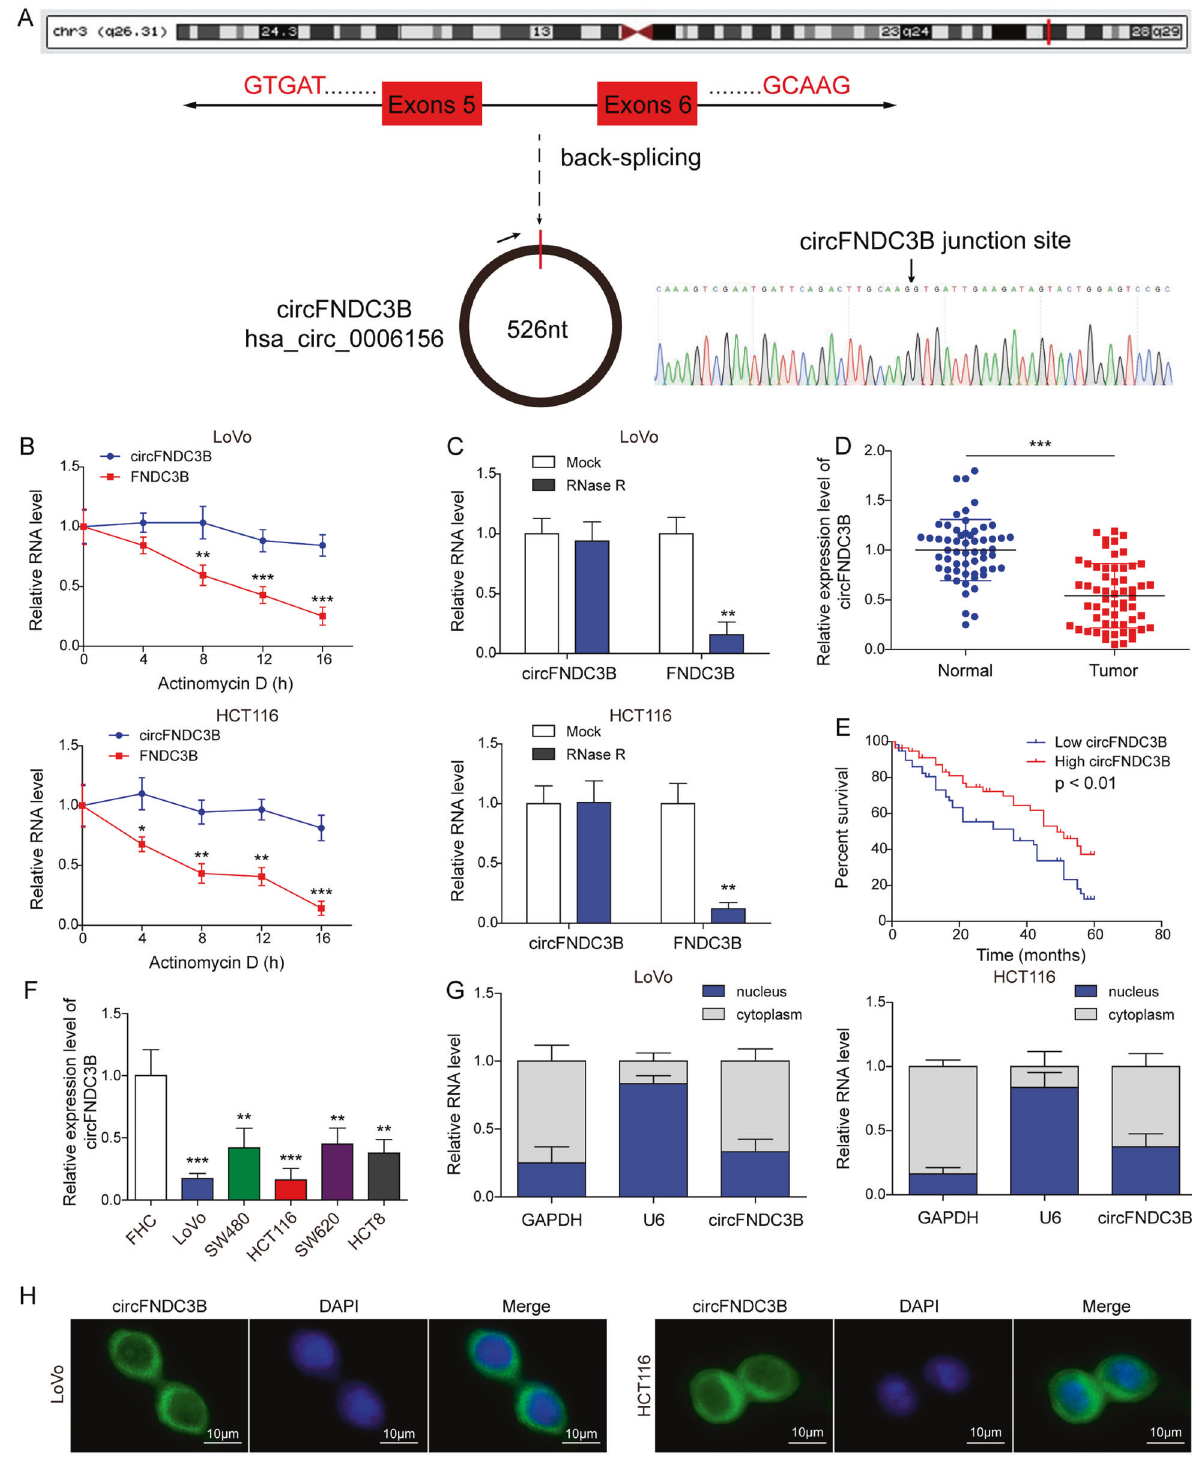
Fig. 1 circFNDC3B is downregulated in CRC tissues and cells, and low circFNDC3B expression is associated with unfavorable overall survival in CRC patients. A Schematic drawing illustrated the formation of circFNDC3B. B , C The expression level of circFNDC3B was detected by qRT-PCR in LoVo and HCT116 cells treated with Actinomycin D or RNase R. D The circFNDC3B level in CRC tissues was detected by qRT-PCR. E The correlation between circFNDC3B level and OS of CRC patients was analyzed by Kaplan – Meier method. F The circFNDC3B level in CRC cells was detected by qRT-PCR. G The circFNDC3B level in LoVo and HCT116 cells was detected by subcellular fractionation. H The subcellular localization of circFNDC3B was detected by RNA FISH in LoVo and HCT116 cells. Scale bar, 10 μ m; Green, circFNDC3B; Blue, DAPI. ** P < 0.01, *** P < 0.001.